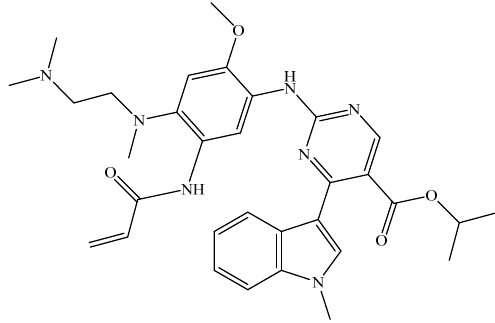
Figure 1. Chemical structure of mobocertinib.